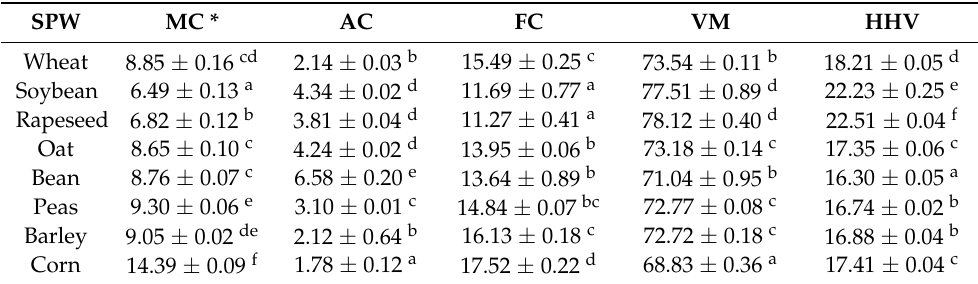
Table 1. Proximate analysis of individual SPWs (oven dry basis). Statistically significant differences (at p < 0.05) are shown by different superscript letters in the vertical columns ( n = 4).